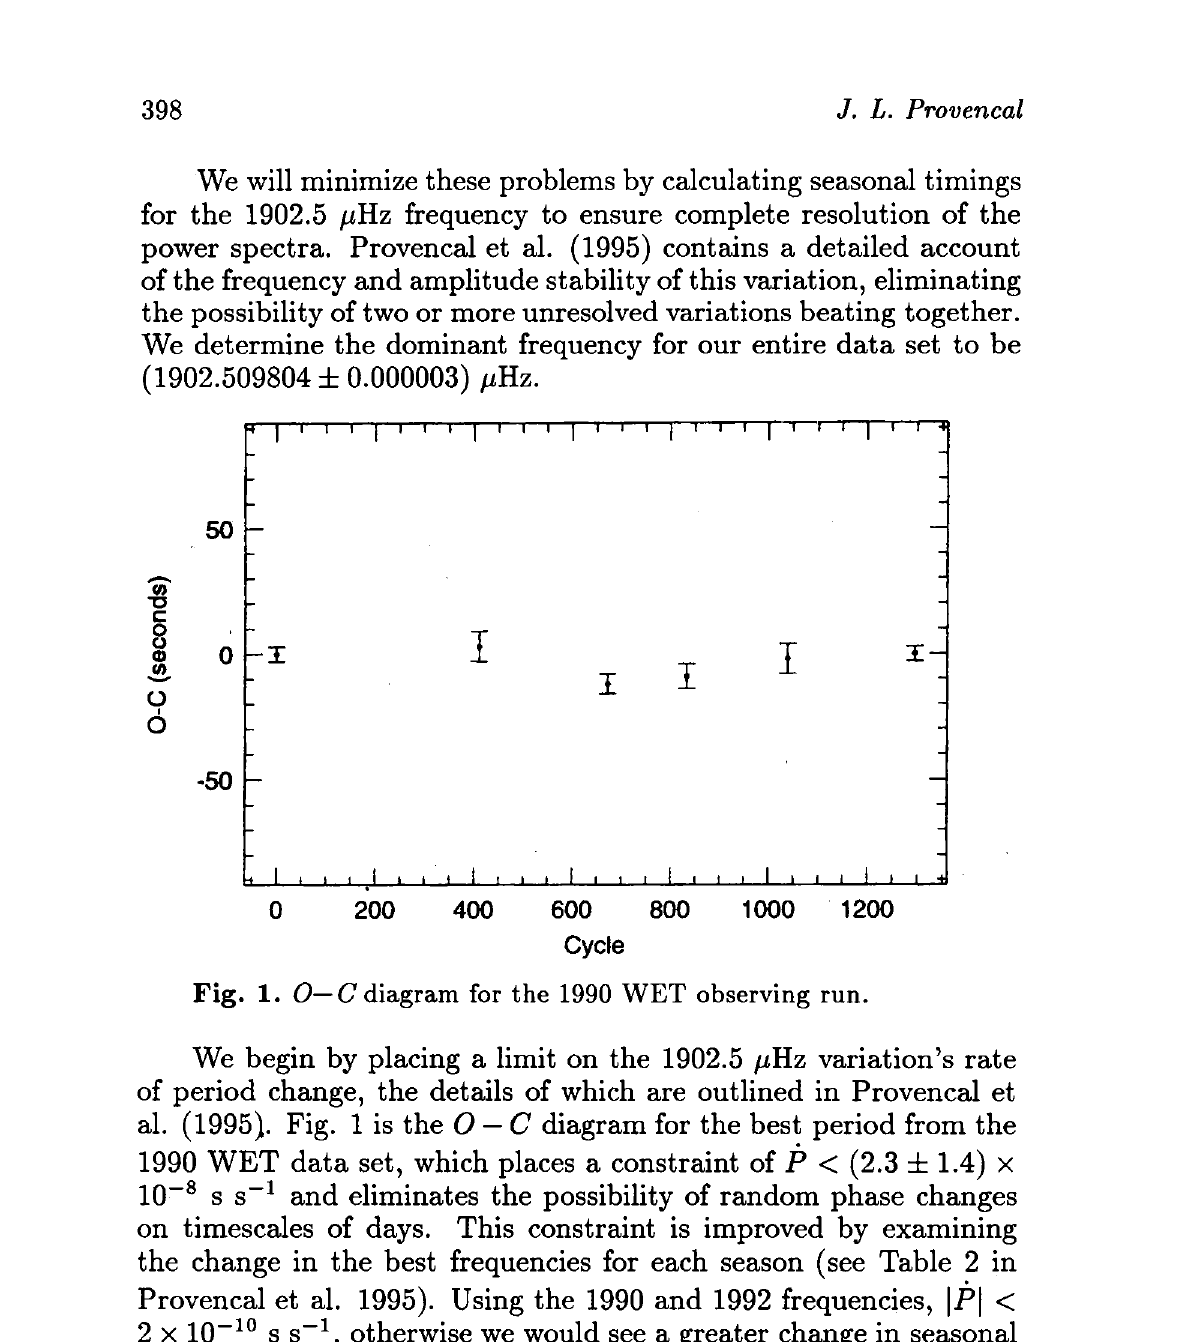
Fig. 1. O—C diagram for the 1990 WET observing